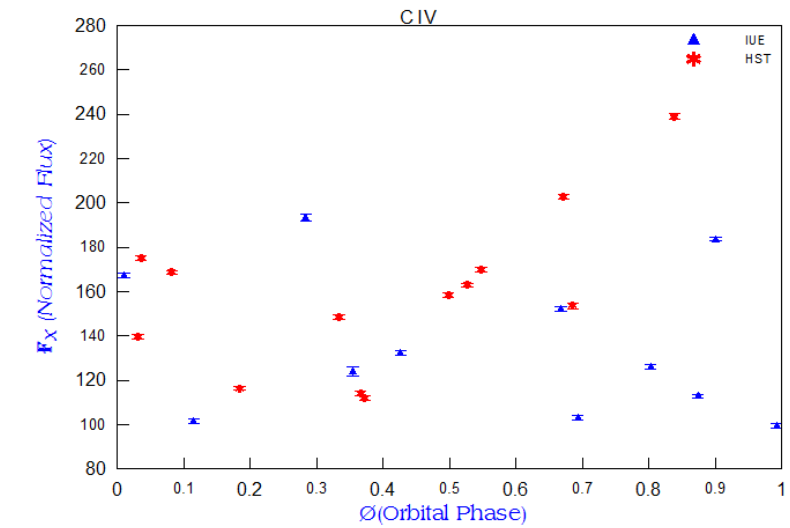
Fig. 8 Variation of the C IV line flux with phase of DQ Her The 1 σ error bars are shown on each data